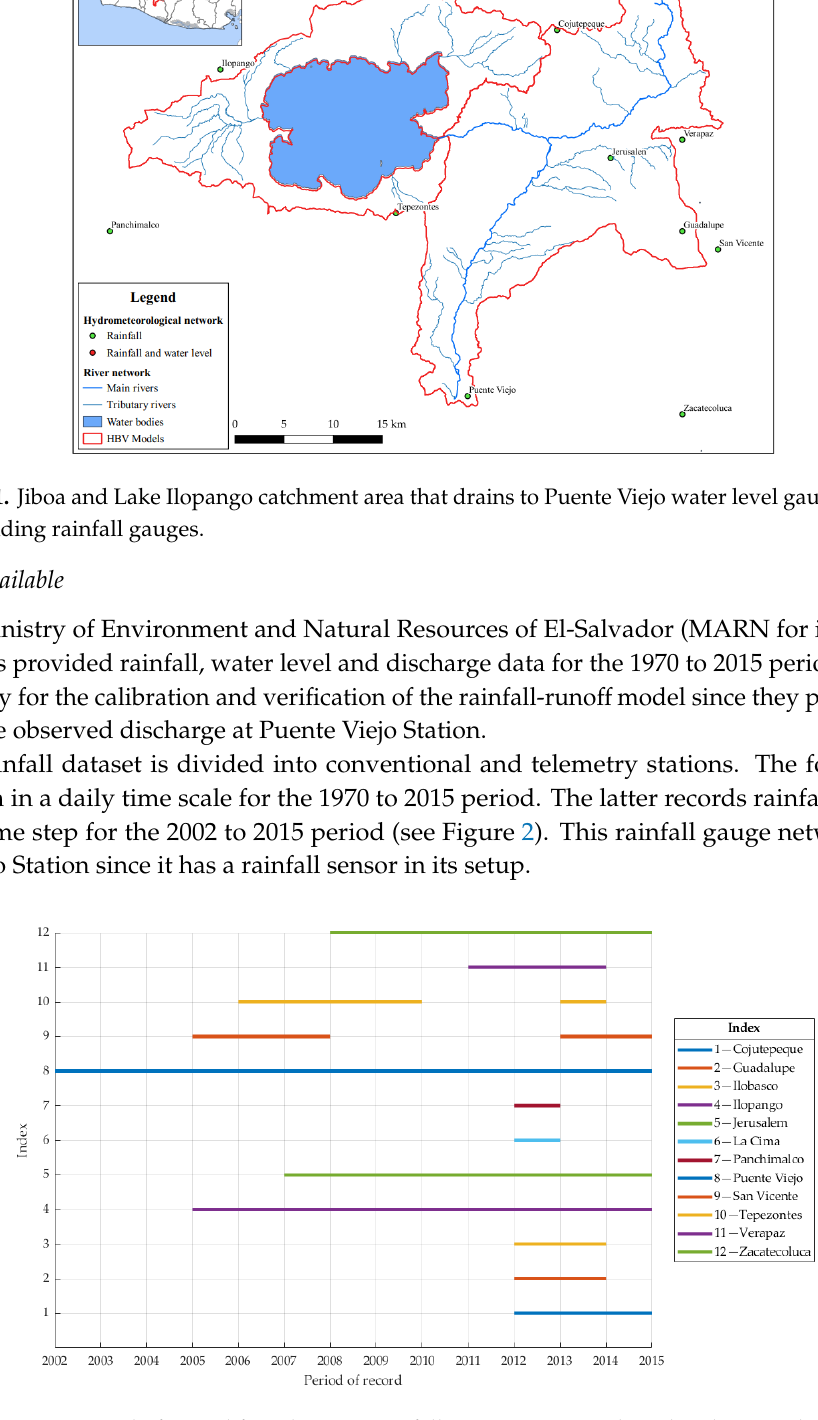
Figure 1. Jiboa and Lake Ilopango catchment area that drains to Puente Viejo water level gauge and the surrounding rainfall gauges.